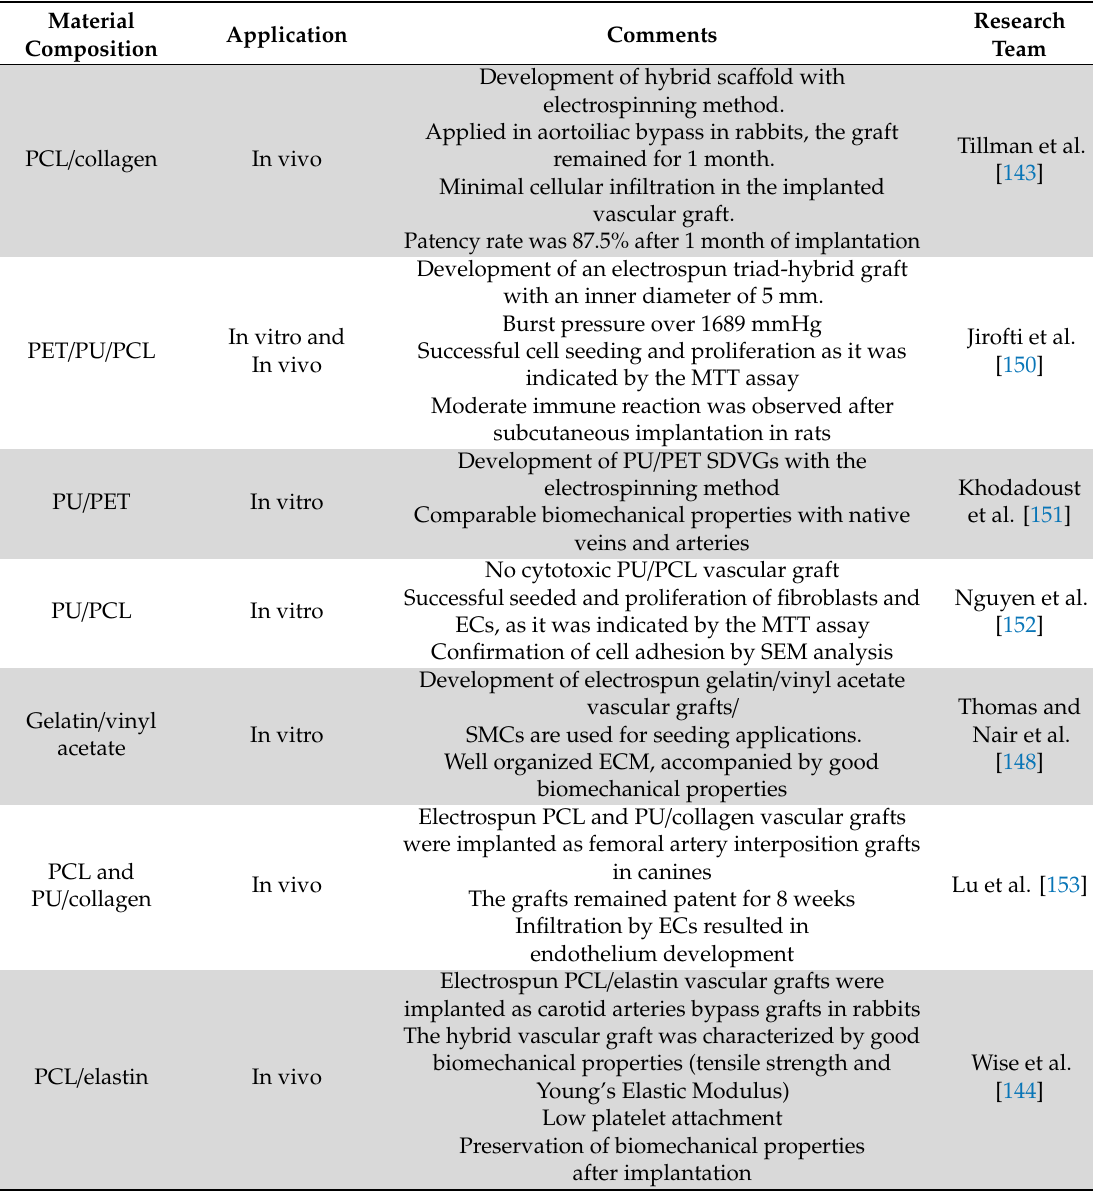
Table 4. Representative applications of TEVGs derived from hybrid